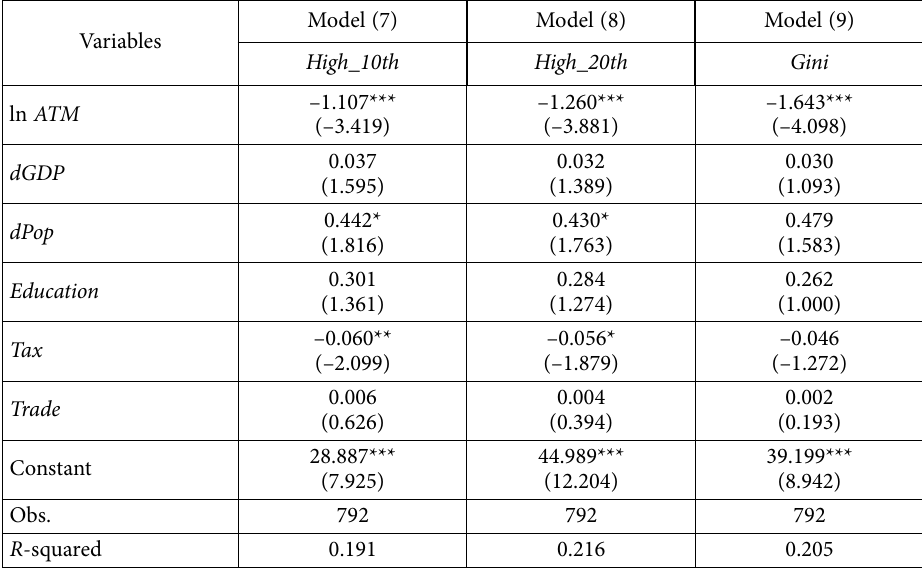
Table 3. Results of the robustness test ( Bank replaced by ATM